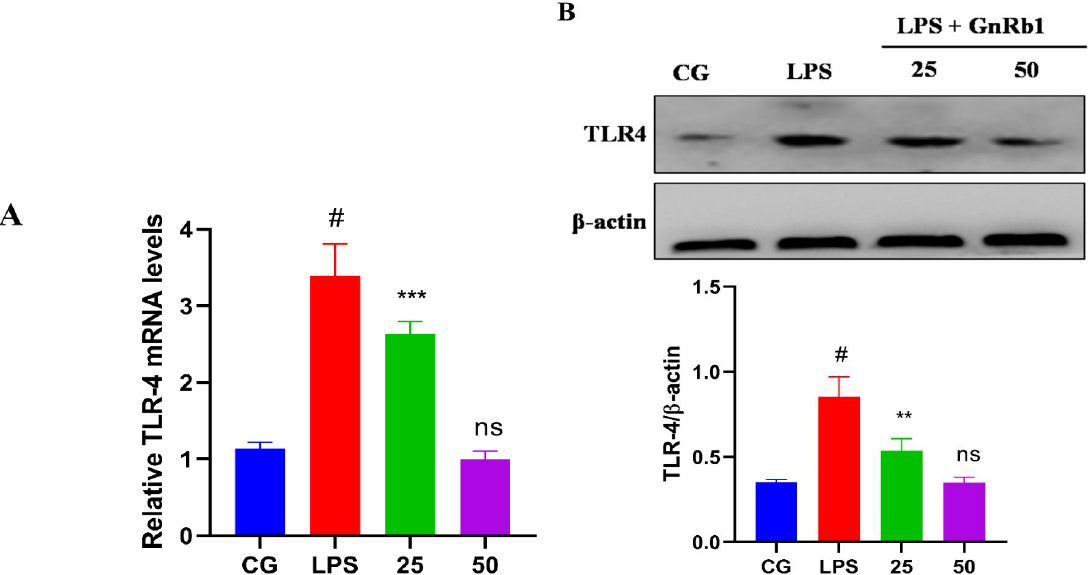
Figure 5. Effects of GnRb1 against LPS-induced production IL-10 concentration. The concentration of ( A ) IL-10 (pg/mL). The relative mRNA expression level of ( B ) IL-10 in uterine tissue. CG represents the control group. LPS reveals the LPS- induced groups. The 25 and 50 are the GnRb1-administrated groups representing 25 mg/kg and 50 mg/kg per animal, respectively. GnRb1 indicates the Ginsenoside Rb1. Data statistics are demonstrated as mean ± S.E.M. The ** p < 0.001 CG versus LPS group, ** p < 0.01, *** p < 0.001, **** p < 0.0001, and ns indicates the nonsignificant difference between CG versus LPS + GnRb1 groups.